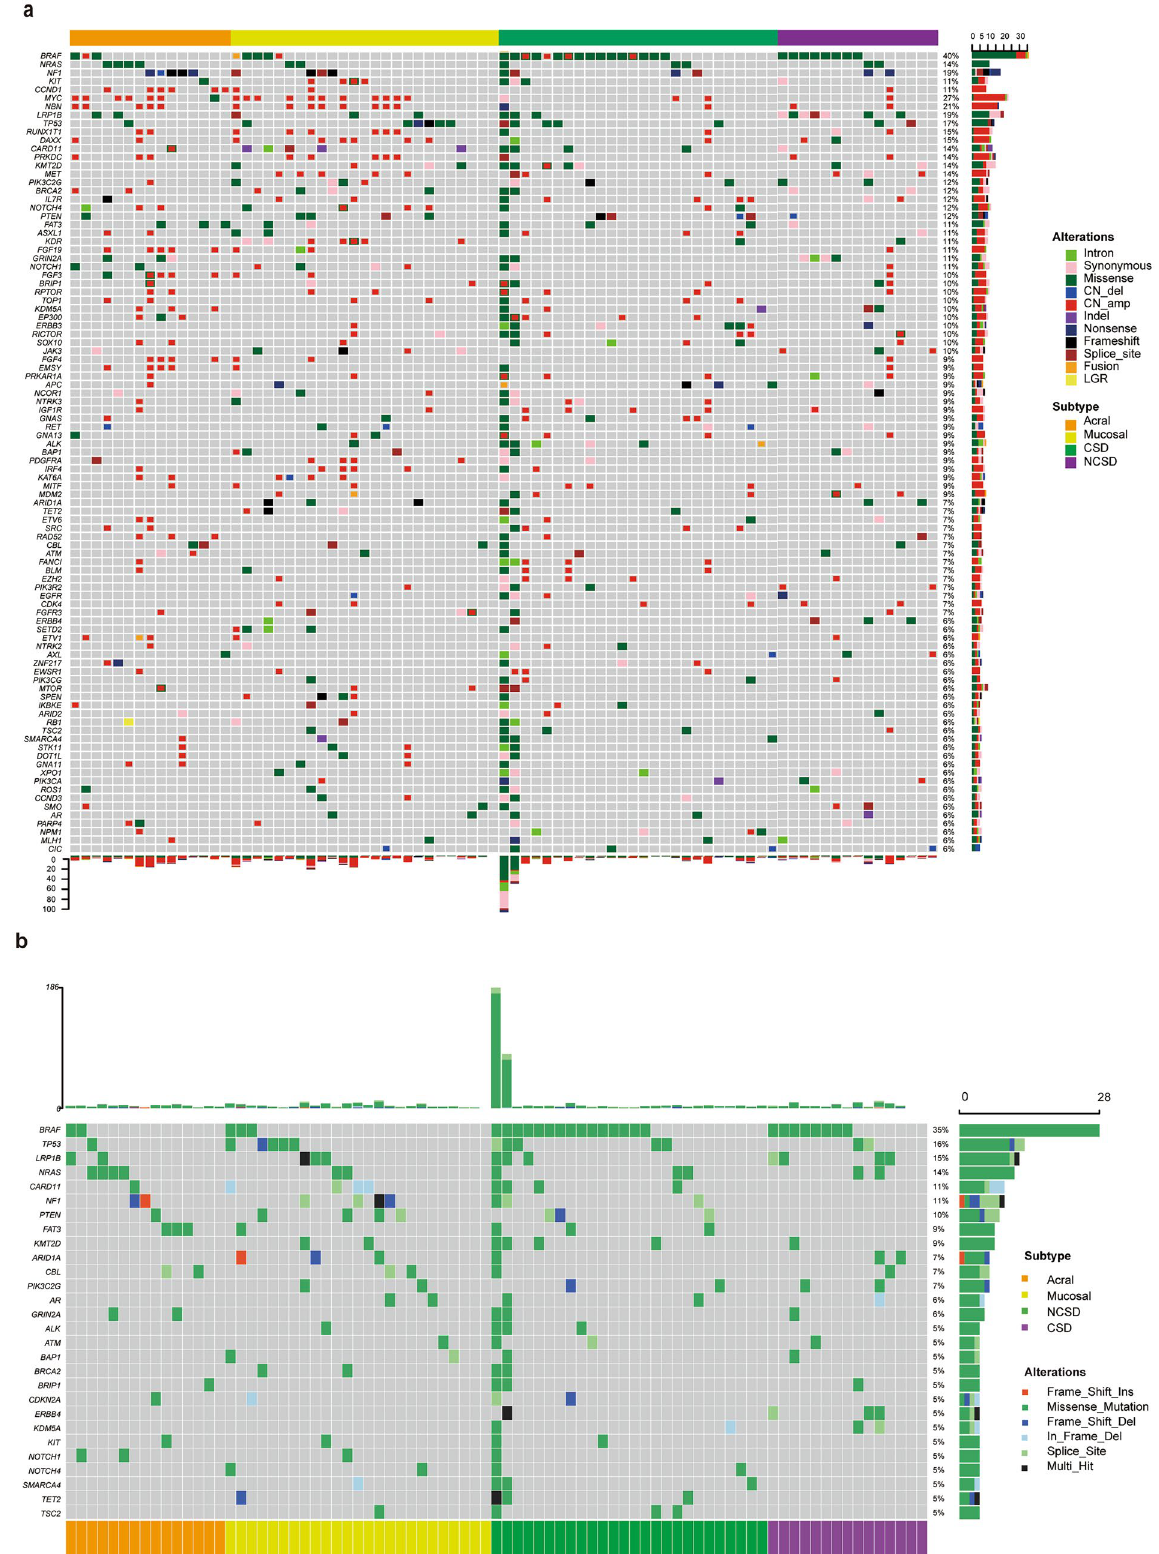
Figure 1. Genomic profiles and mutation characteristics of cutaneous, mucosal and acral melanoma. Each column represents an individual tumor underwent NGS. ( a ) Genomic profiles of 3 subtypes of melanoma (cutaneous melanoma means CSD and NCSD), including 95 genes with variant frequency over 5%. Alterations colored by different types. Main driver genes (BRAF, NRAS, NF1, KIT) were shown on the top of heatmap. ( b ) Oncoplot of mutations in mutated genes with mutation rate over